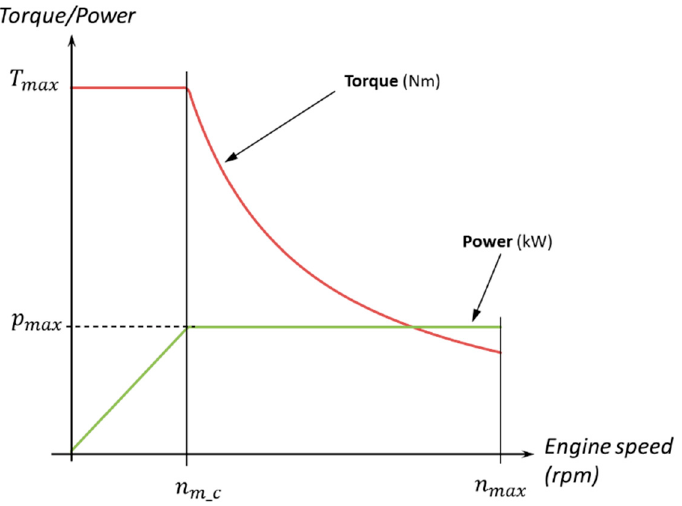
Figure 3. Torque and power curves of an electric motor.